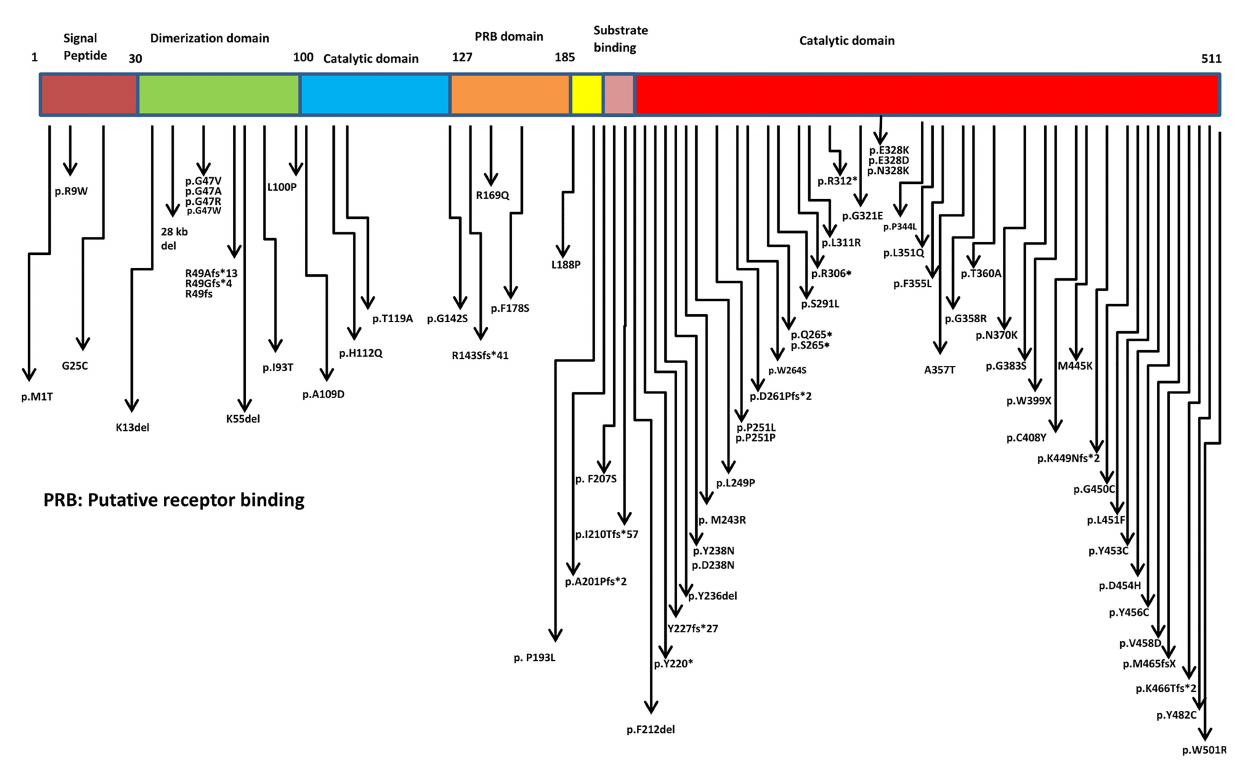
FIGURE 2 | Schematic representation of mutations in ADA2